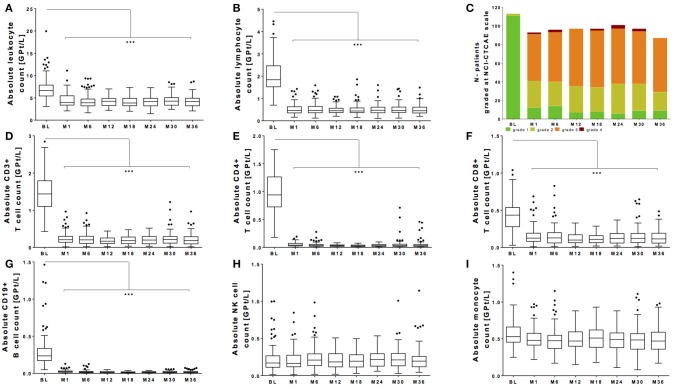
Absolute count of peripheral white blood cells during fingolimod treatment. Absolute cell counts of leukocytes (A) lymphocytes (B), CD3+ T cells (D), CD4+ T cells (E), CD8+ T cells (F), CD19+ B cells (G) and NK cells (H), and monocytes (I) are depicted. Data for the whole cohort are shown as Boxplot Tukey before fingolimod start (baseline, BL), month 1 and every 6 months follow up. (C) Distribution of different ranges of lymphocyte count are shown graded with NCI-CTCAE: lymphopenia grade 1 >0.8 GPt/L (green), lymphopenia grade 2 0.5-0.8 GPt/L (yellow), lymphopenia grade 3 0.2-0.5 GPt/L (orange) and lymphopenia grade 4 < 0.2 GPt/L (red). Asterisks indicate level of significance of pairwise comparison (***p < 0.001).